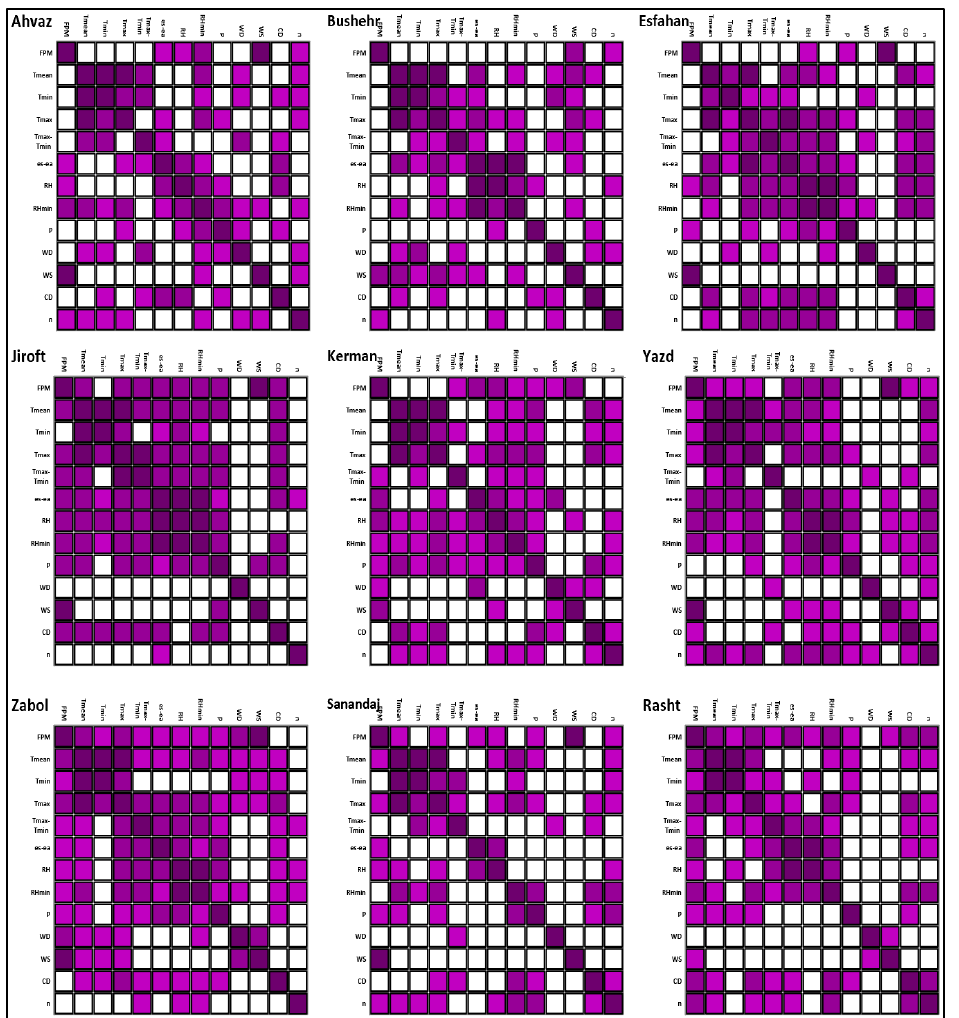
Figure 7. Spearman’s Rho correlation coefficient (ρ) maps for weather stations located in arid, Mediterranean, and humid regions. Colored boxes show a significant correlation at the confidence level of 95%. Dark, medium, and light purples denote 0.8 ≤ ρ ≤1, 0.5 ≤ ρ < 0.8, and ρ < 0.5, respectively).